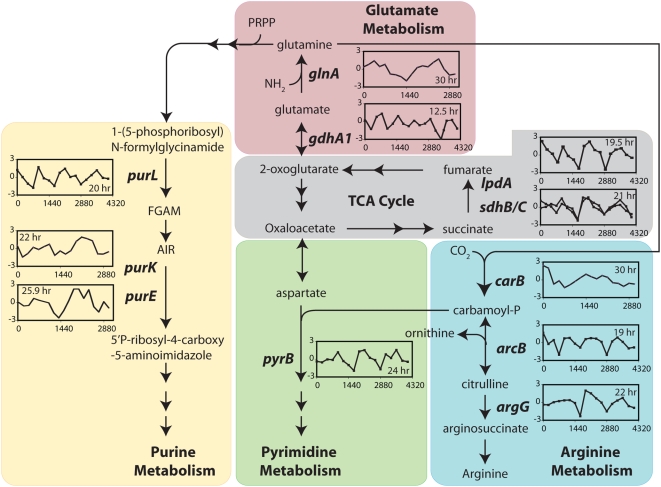
Periodic expression of genes in five linked processes.Integrated analysis of transcriptional changes from a physiological context identified periodic expression of genes encoding key steps in energy production (TCA cycle and arginine metabolism), C- and N- assimilation (glutamate and arginine metabolism) and nucleotide biosynthesis. The inset graphs show transcriptional profiles (log10 ratios) of gene with a specific period.